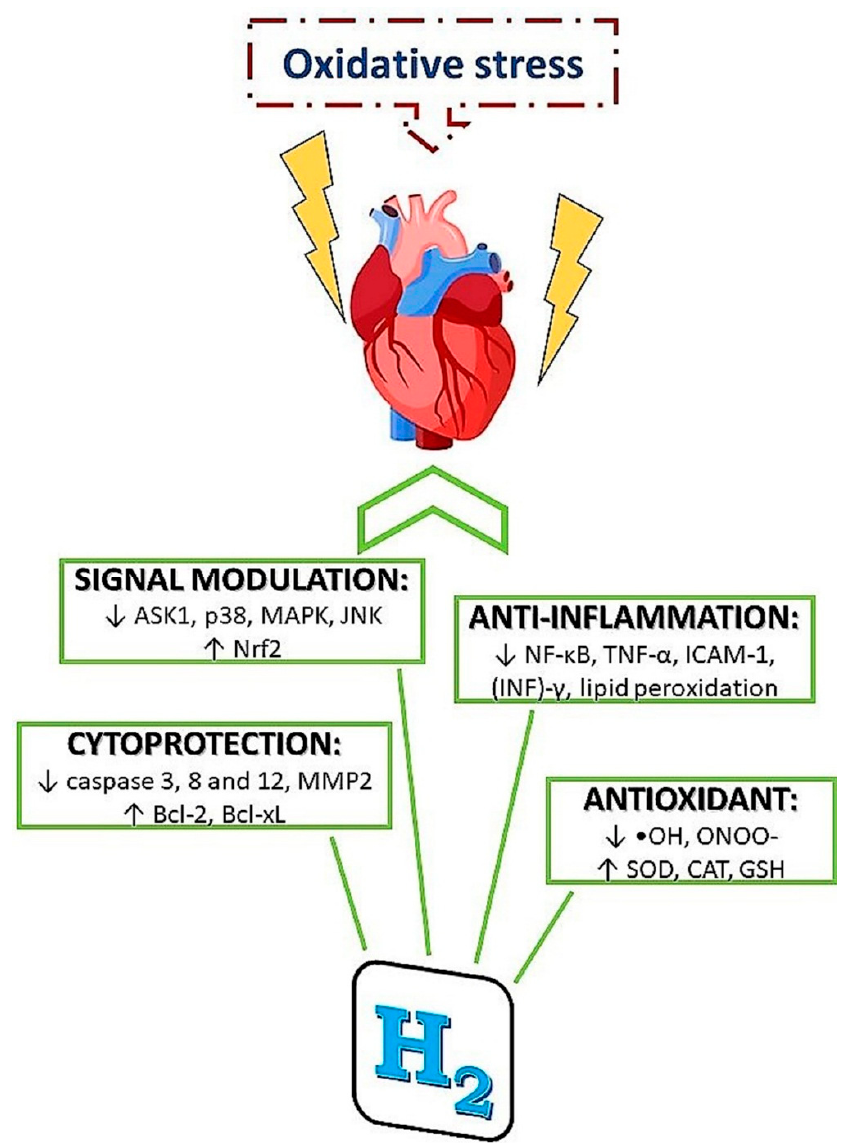
Figure 4 . Mechanisms of molecular hydrogen action in condition of increased oxidative stress. Figure 4. Mechanisms of molecular hydrogen action in condition of increased oxidative